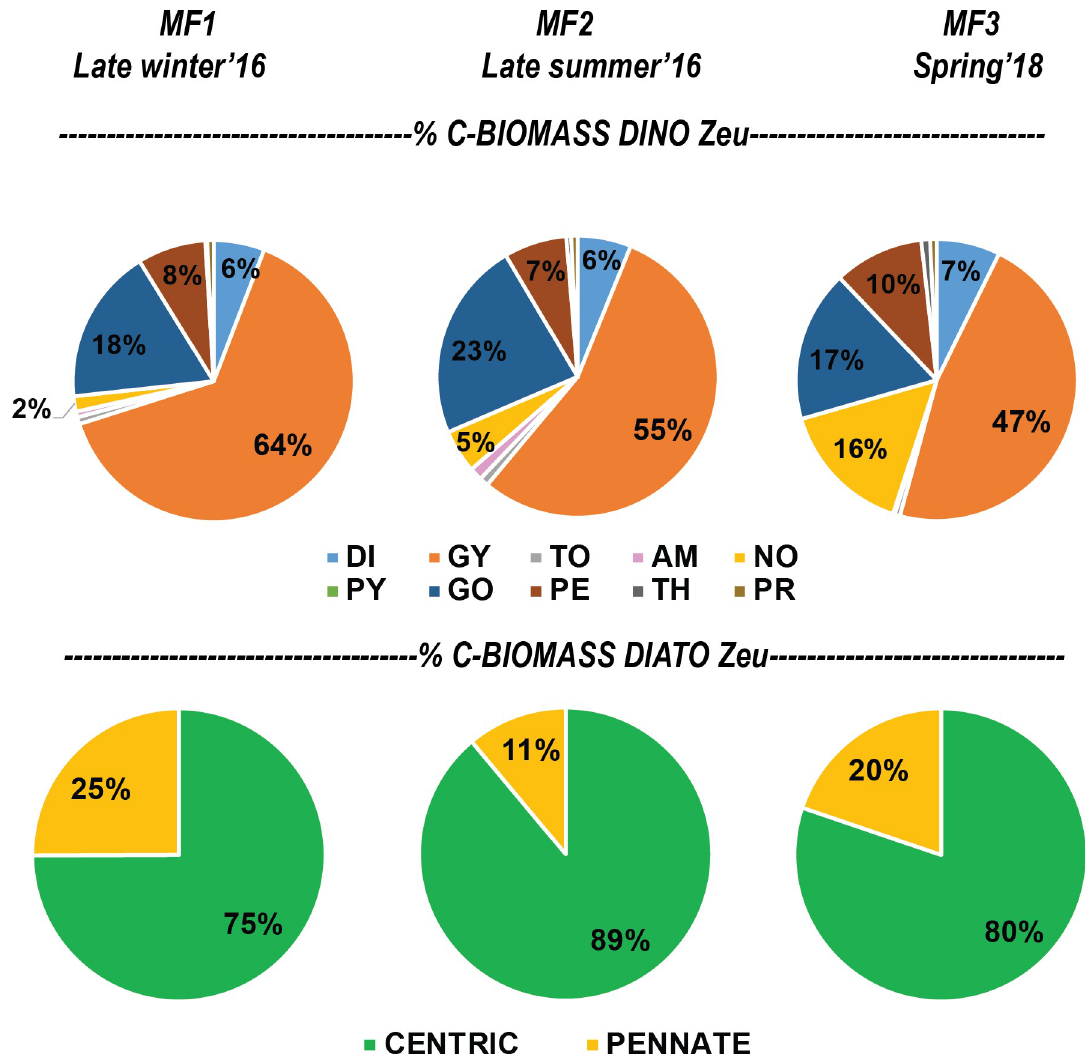
Fig 8. Relative per-cruise percentage of depth-integrated carbon biomass for dinoflagellate orders and diatom shapes. Carbon biomass contribution (%) of dinoflagellate orders and diatom shapes in the euphotic zone (Zeu: surface to ~150 m depth) during MF1 (late winter 2016), MF2 (late summer 2016), and MF3 (spring 2018) cruises. Dinoflagellate orders: DI, Dinophysales; GY, Gymnodiniales; TO, Tovelliales; AM, Amphidiniales; NO, Noctilucales; PY: Pyrocystales; GO, Gonyaulacales; PE, Peridiniales; TH, Thoracosphaerales; PR, Prorocentrales. Diatom shapes: CENTRIC and PENNATE.